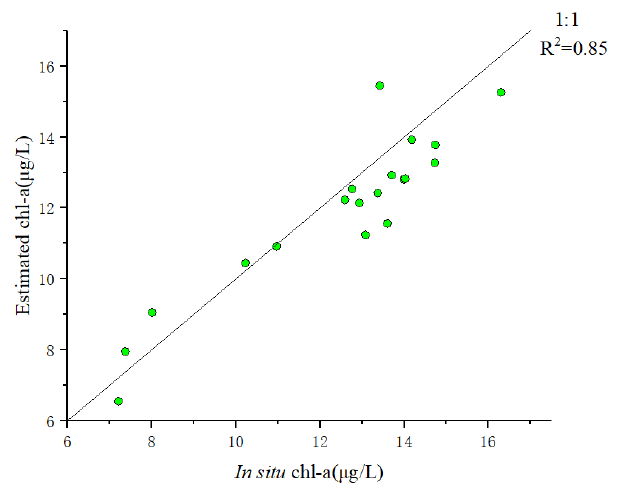
Figure 9. Scatter plot of in situ versus ZY1-02D-derived Chl-a